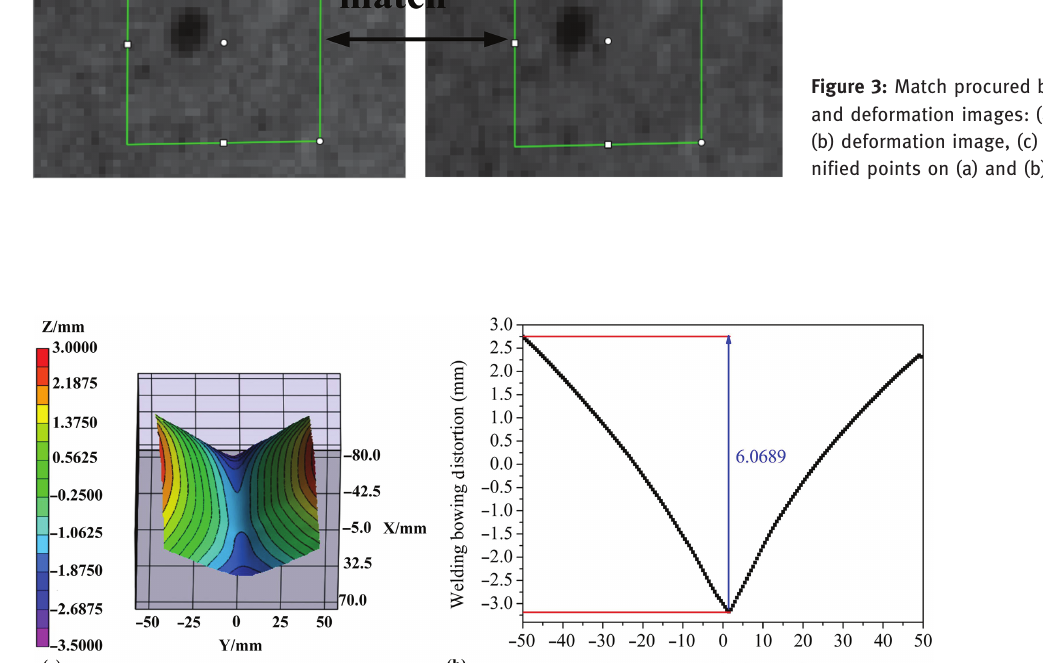
Figure 4: 3D deflection contour of the plate and the evaluated weld bowing distortion (laser power, P = 1000 W; welding speed, v = 6mm/s; defocus distance, D = − 1mm; gas flow rate, G =